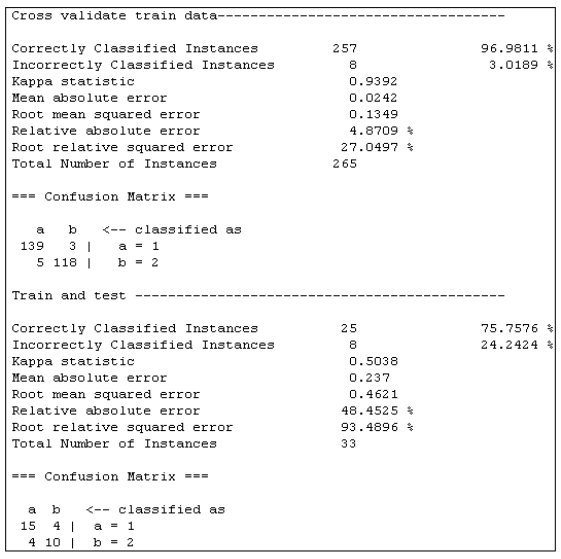
Figure 2: Sample text file that is created after performance measures calculation